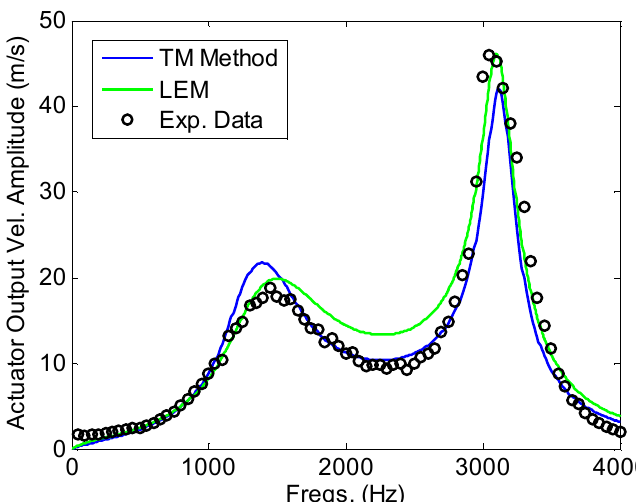
Fig. 13 Iterative method for jet velocity calculation. I is current at input port and is the volume velocity at the other port.